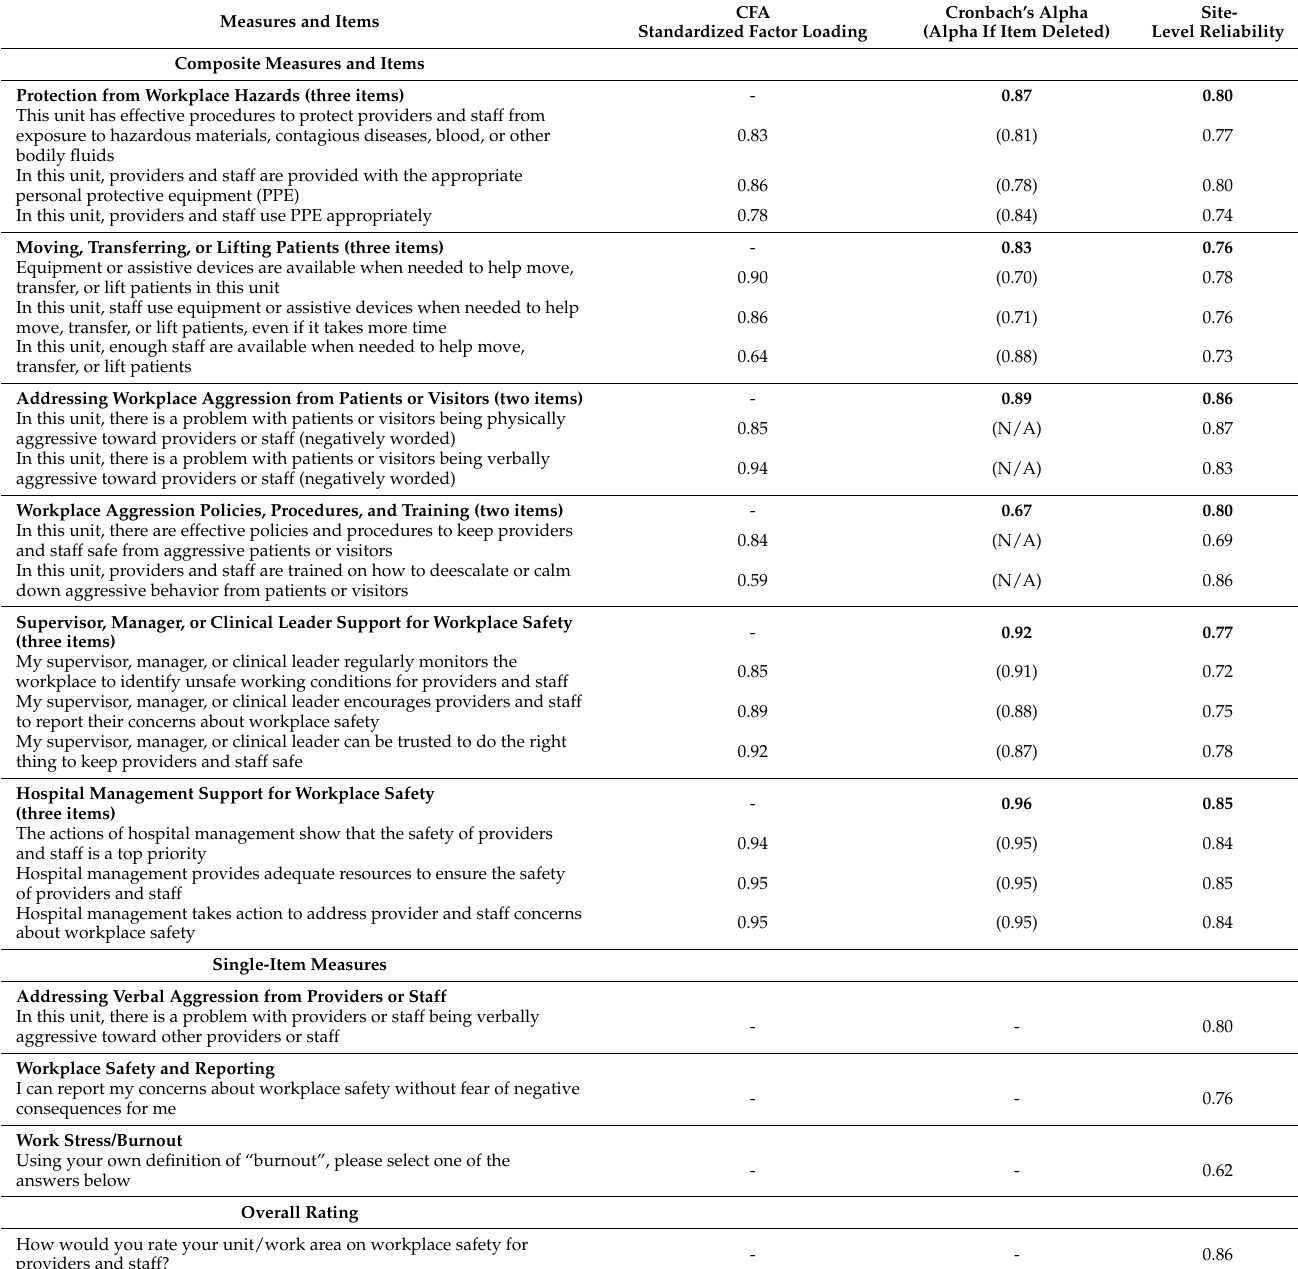
Table 7. CFA standardized factor loadings, final internal consistency reliability, and site-level